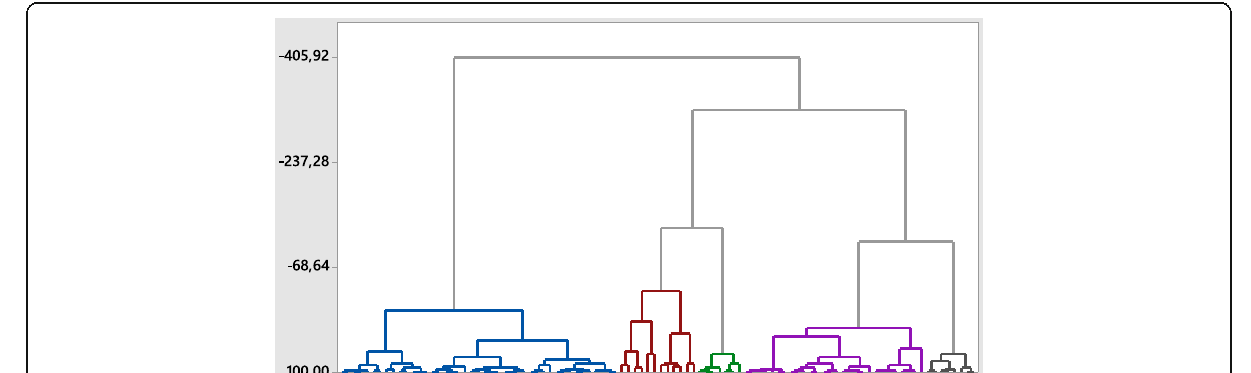
Fig. 4 Dendrogram of the optimized network – Complete linkage - Euclidean